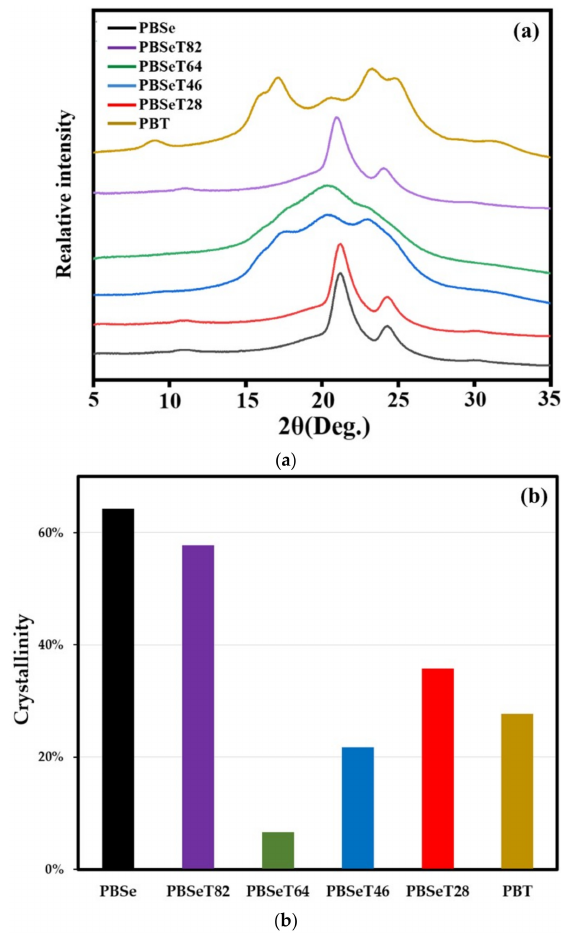
Figure 8. ( a ) WAXD curves and ( b ) crystallinity of the synthesized random copolymers with various sebacate:dimetylterephthalate molar